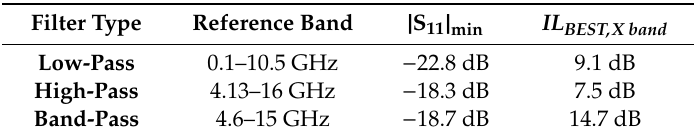
Figure 7. Transmission coe ffi cient | S 21 | for the HPF at 3 V. The reference frequencies and values of | S 21 | are highlighted for an estimation at a glance of filter’s rejection properties. Table 2. Main performance of the three filters in terms of reference band, minimum value of | S 11 | in the reference band, and best value of the insertion loss in the X